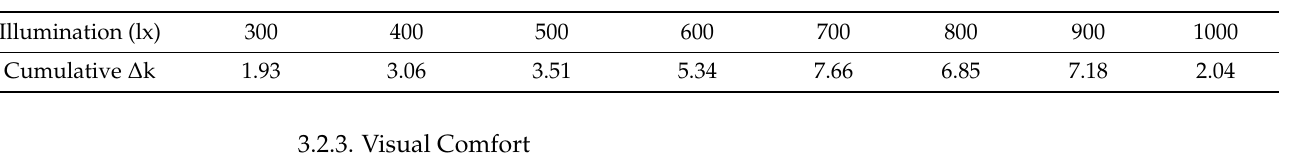
Table 8. Spearman correlation coefficient of illumination and visual comfort score.